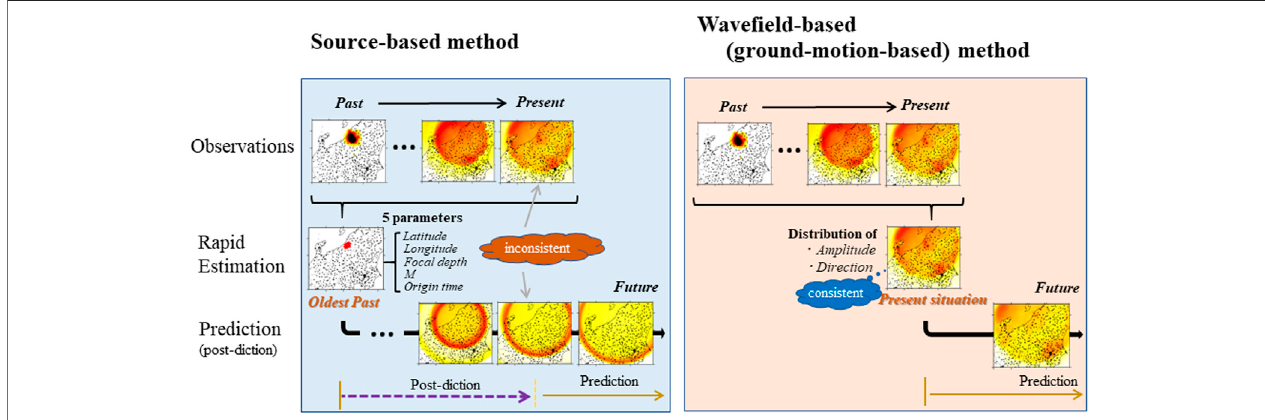
FIGURE 7 | Comparison of the wave fi eld-based (ground-motion-based) method and the source-based method. This fi gure and comparison of the two methods arepresentedindetailintheSummary.Inthesource-basedmethod,welookbacktothe “ oldestpastsituation ” torepresentitby fi veparameters,andthenexpandagain to reconstruct the spatial distribution from the oldest past situation. In the wave fi eld-based method, all data up to the present are used to estimate “ present situation, ” and then we predict future spatial distribution from the present situation.